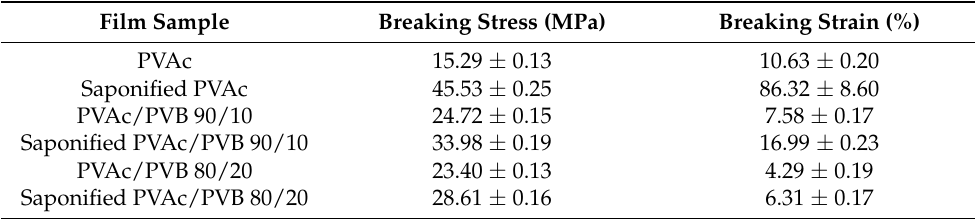
Figure 8. Stress–strain curves of film samples at strains of ( a ) 0 to 120% and ( b ) 0 to 30%. Table 4. Breaking stress and breaking strain of saponified and unsaponified film samples.